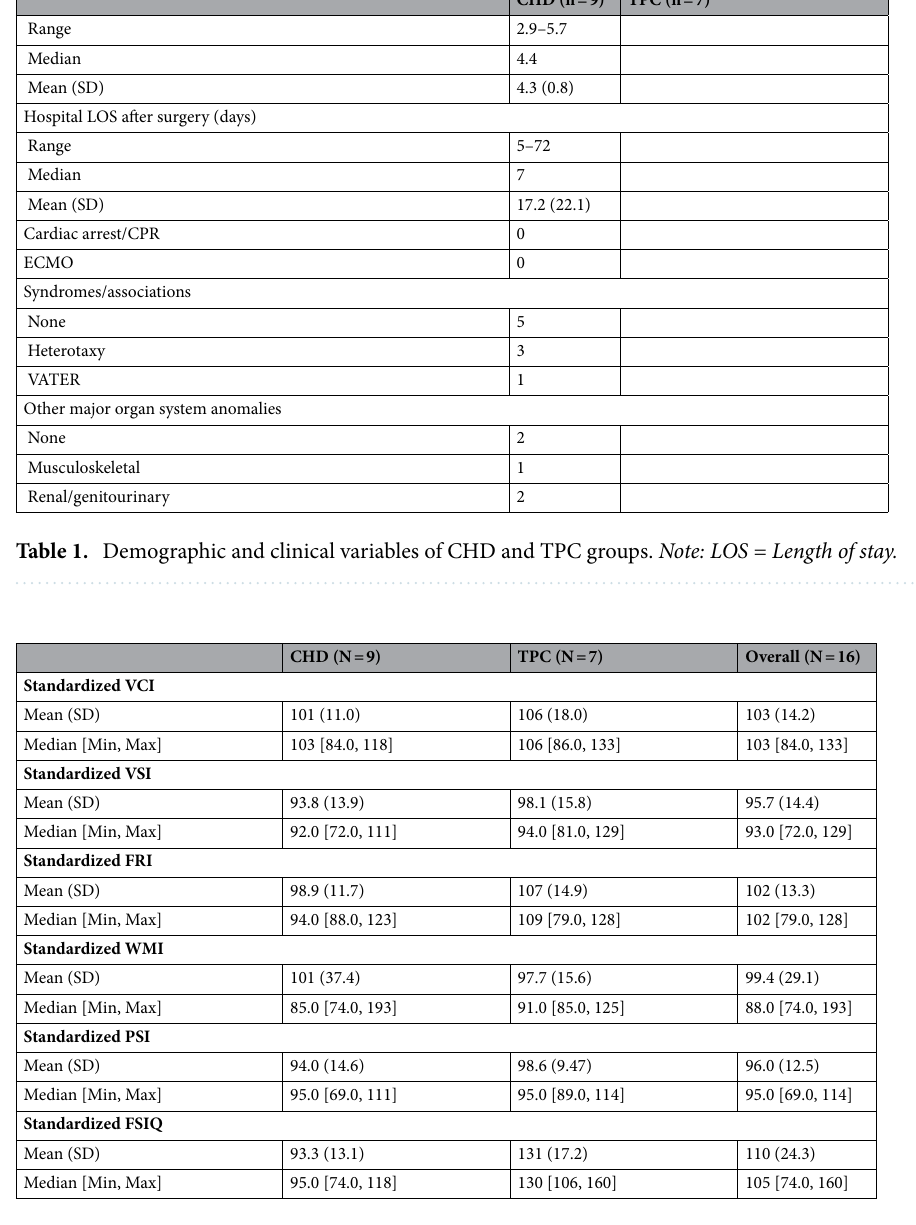
Table 2. Neuropsychological assessment variables for CHD and TPC